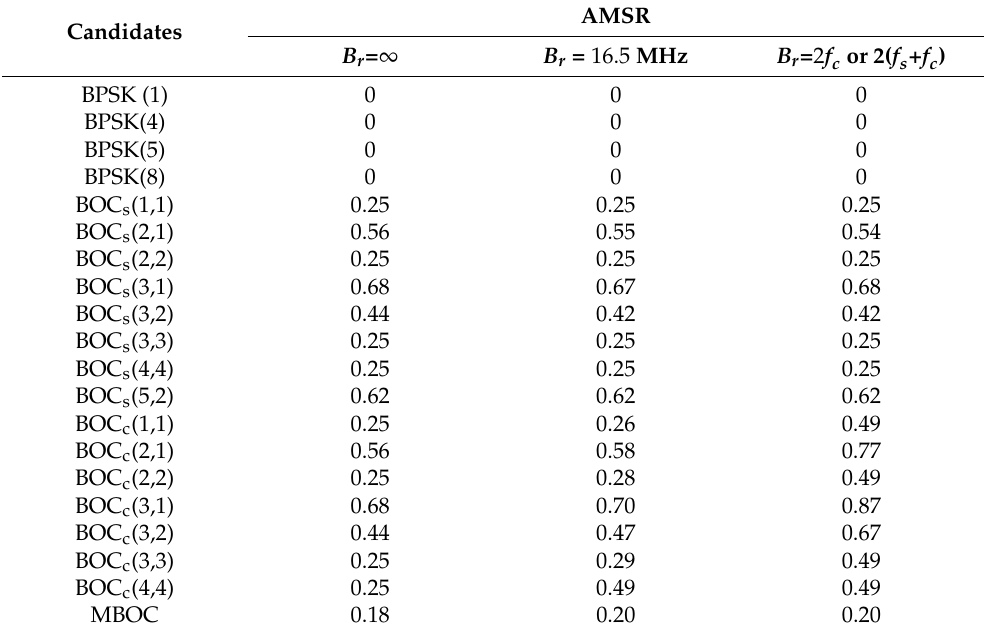
Table 10. Autocorrelation main peak-to-secondary peak ratio ( AMSR) of candidates in the S-band.